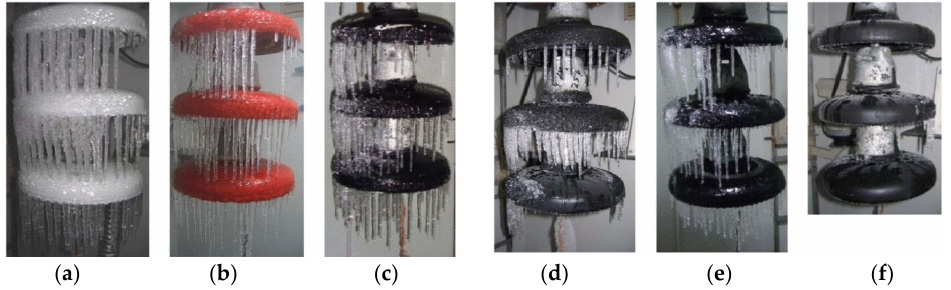
Figure 23. Comparison of insulator ice accretion with different carbon black content coatings. ( a ) No